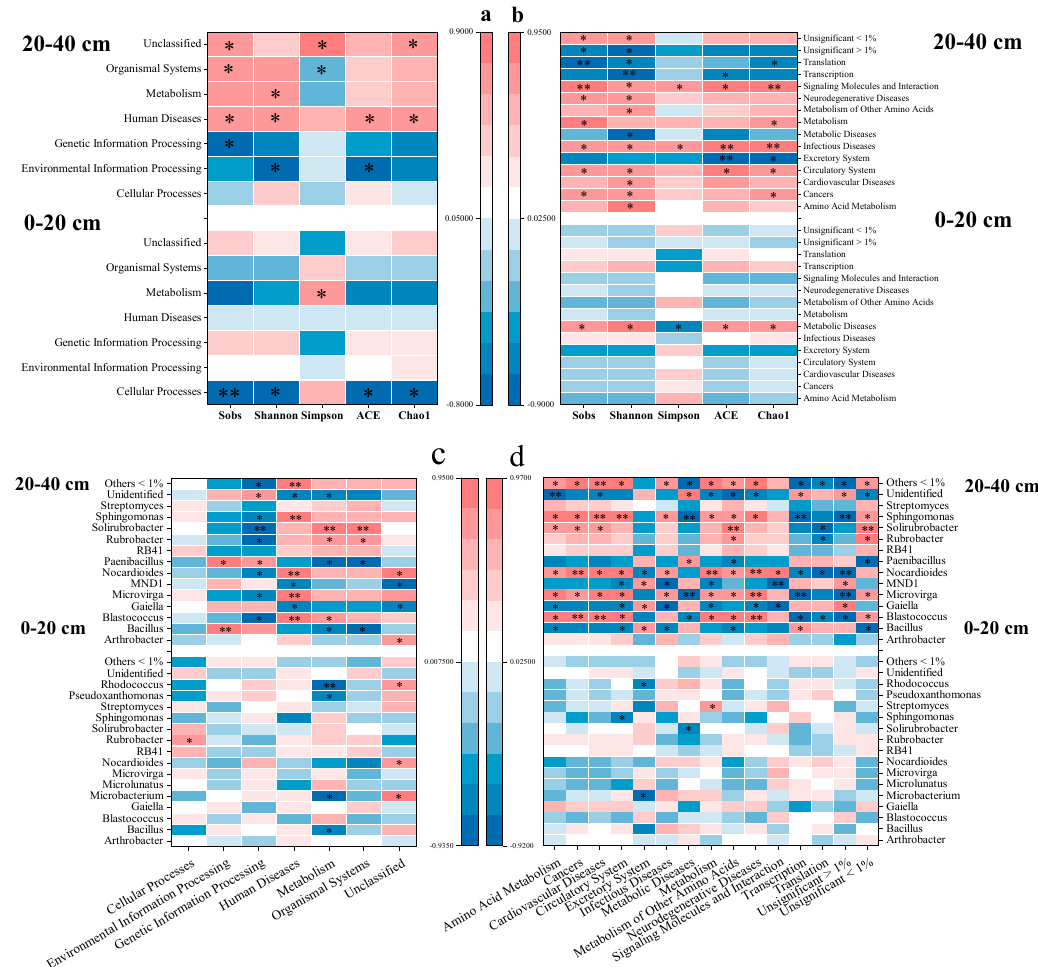
Figure 6. Spearman correlation analysis between taxonomy and functionality of bacterial community. Alpha diversities in relation to functions in biochemical metabolic pathways ( a ) and sub-functions ( b ); genus abundance and functions in biochemical metabolic pathways ( c ) and sub-functions ( d ). * indicates significant correlation ( p < 0.05), while ** indicates extremely significant correlation ( p < 0.01). The results of this study indicated extensive functional redundancy in soil bacterial community at regional ecosystem scale, with distinct bacteria encoding the same